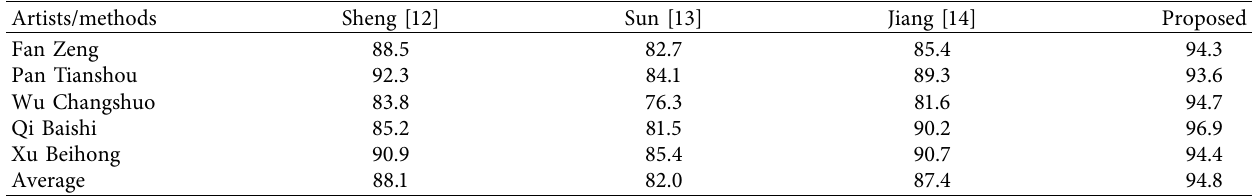
Table 3: Comparison of classification results of different methods on the Case-2 category of the dataset. Artists/methods